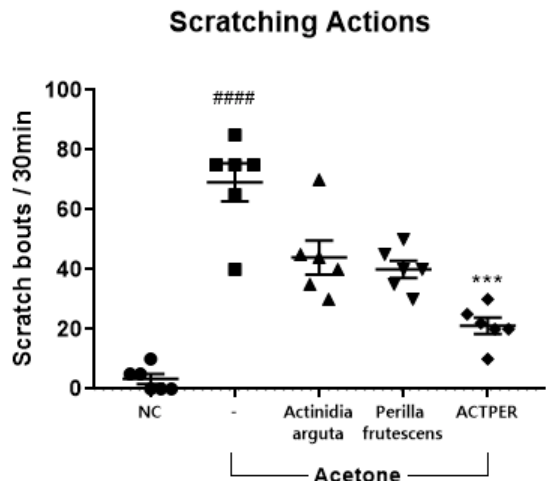
Figure 2. Anti-pruritic effects of Actinidia arguta , Perilla frutescens and ACTPER in acetone-treated mice. Effects of water-soluble extracts from Actinidia arguta, Perilla frutescens, and ACTPER (200 mg/kg) on acetone-induced itch were determined as described in the Materials and Methods section. n = 6 per group. All data are shown as mean ± S.E.M. #### p < 0.0001 compared with control group; *** p < 0.001 compared with vehicle group.